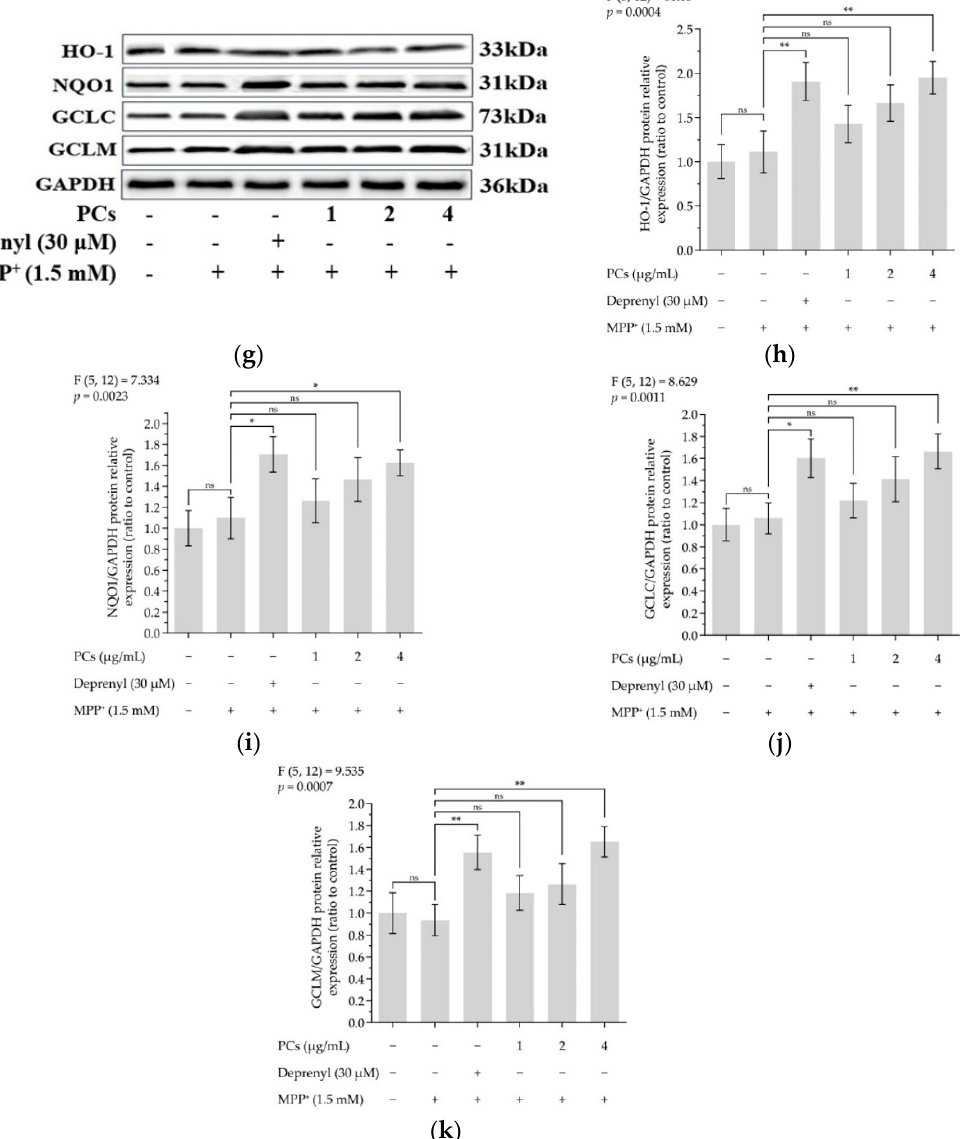
Figure 3. Effects of PCs on Nrf2/ARE pathway in MPP + -induced PC12 cells. ( a ) Protein levels of Nrf2 and Keap-1, as determined by Western blotting; ( b ) Nrf2/GAPDH protein relative expression (ratio to control); ( c ) Keap1/GAPDH protein relative expression (ratio to control); ( d ) protein expression levels of nuclear Nrf2 and cytoplasmic Nrf2, as determined by Western blotting; ( e ) nuclear Nrf2/LaminB protein relative expression (ratio to control); ( f ) cytoplasmic Nrf2/GAPDH protein relative expression (ratio to control); ( g ) protein levels of HO-1, NQO1, GCLC and GCLM, as determined by Western blotting; ( h ) HO-1/GAPDH protein relative expression (ratio to control); ( i ) NQO1/GAPDH protein relative expression (ratio to control); ( j ) GCLC/GAPDH protein relative expression (ratio to control); ( k ) GCLM/GAPDH protein relative expression (ratio to control). F and p values of the one-way analysis of variance are presented above each chart. The results of Tukey’s post hoc test are presented for selected comparisons: ns, p > 0.05; *, p < 0.05; **, p < 0.01; the error bars are SD.